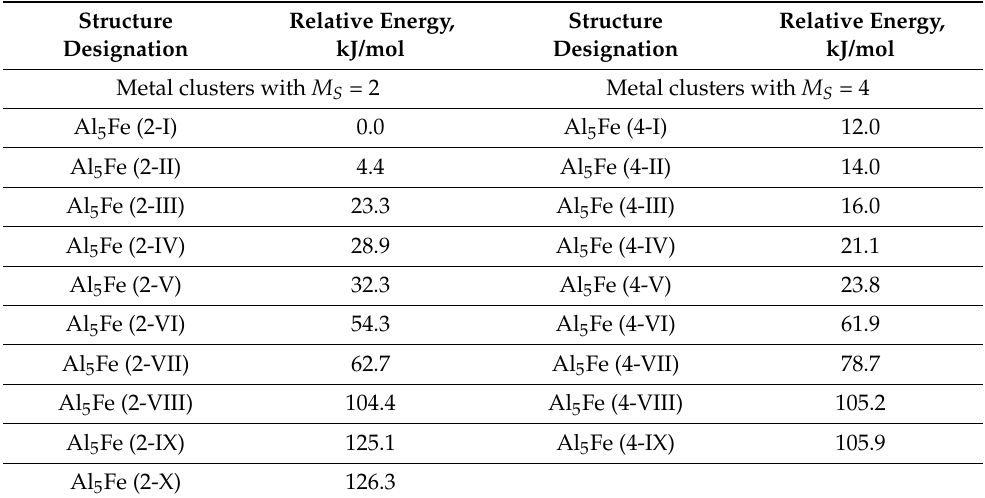
Table 1. Relative energies and spin multiplicities of the ground states of various structural isomers of metal clusters with an Al 5 Fe